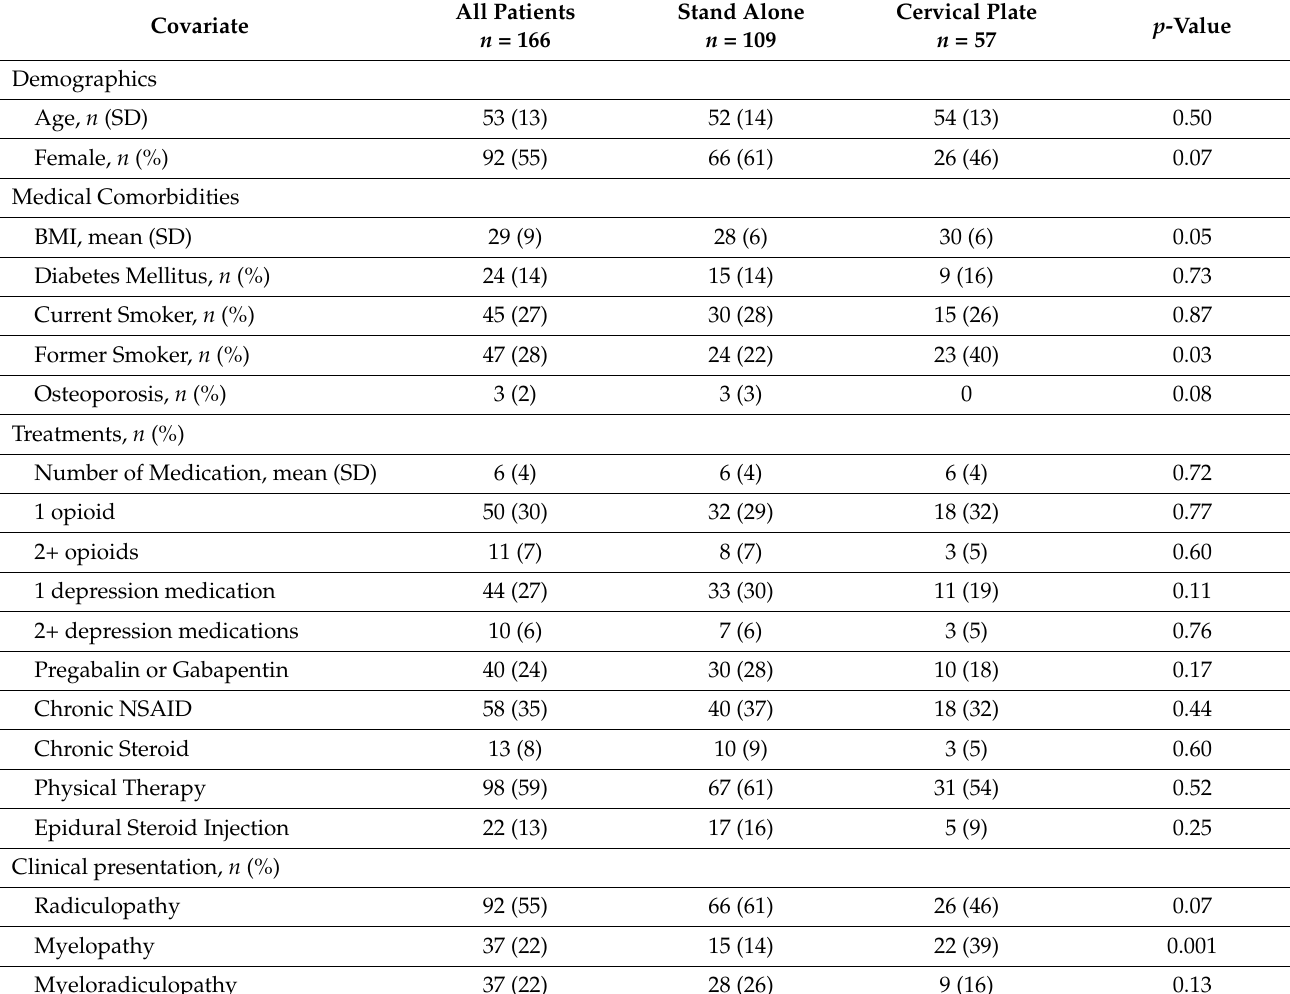
Table 1. Population Characteristics.